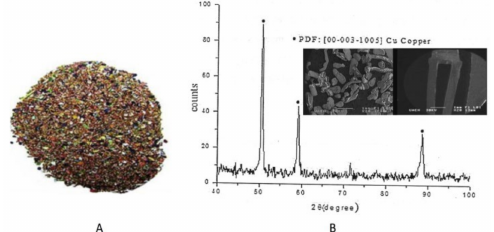
Figure 1. ( A ) Material used in the conducted series of experiments and ( B ) XRD spectrum and SEM (SE) images showing the morphology of the material.